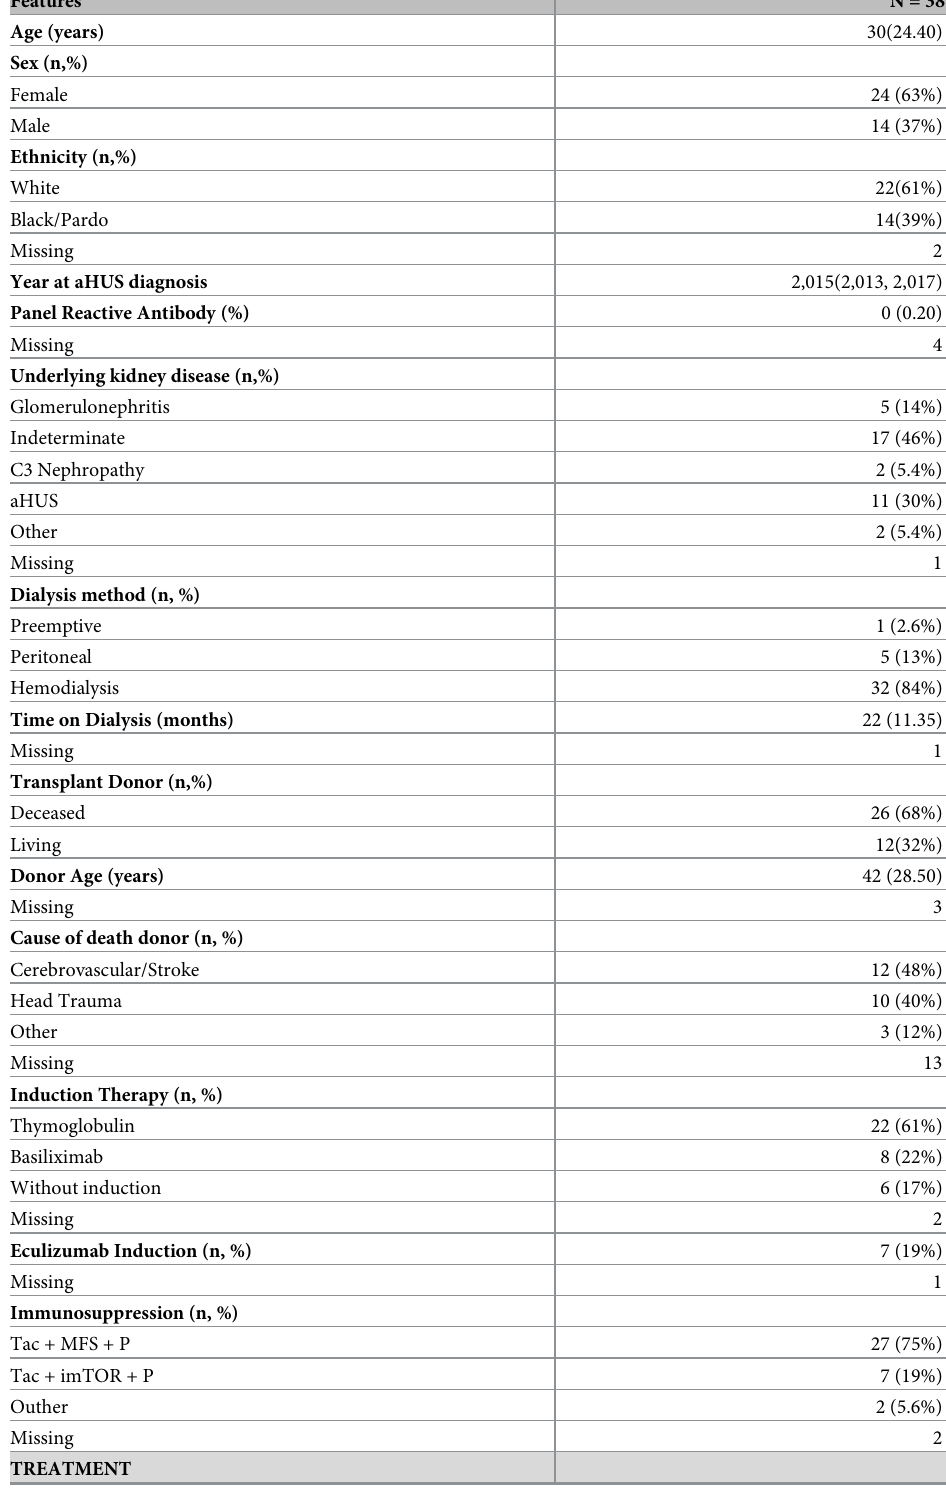
Table 1. Demographic data of Brazilian aHUS cohort patients in renal